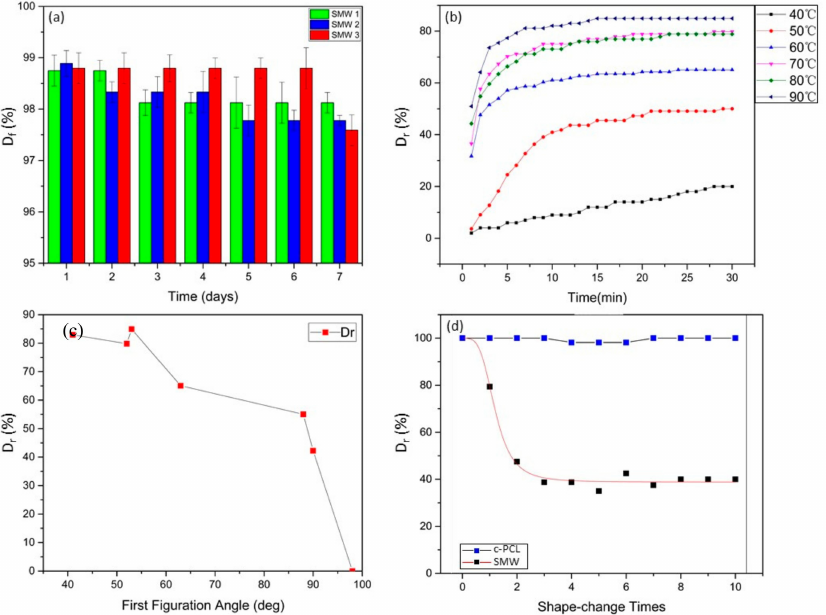
Figure 10. Shape memory properties of shape memory wood: ( a ) Relationship between shape fixity ratio ( D f ) and time of SMW; ( b ) relationship between shape recover ratio ( D r ) and time of SMW in di ff erent heating temperature; ( c ) relationship between shape recover ration and first figuration angle degree of SMW; ( d ) relationship between shape recover ration and shape-change times of SMW,